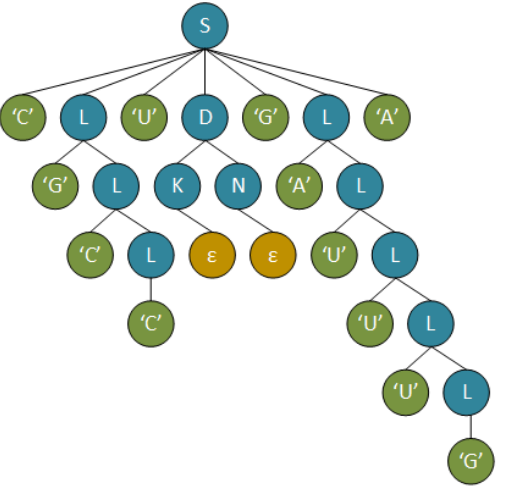
Figure 5. Parse-tree-recognizing pseudoknot is substring “C G C C U G A U U U G